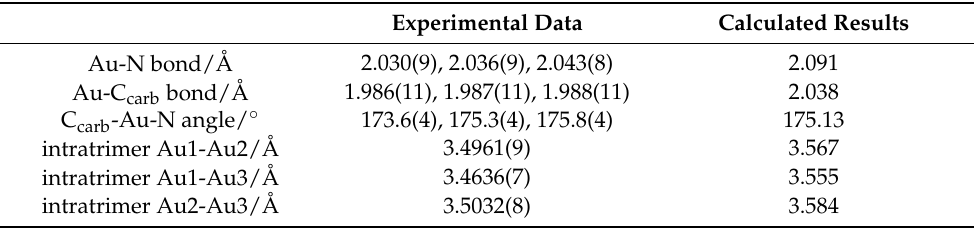
Table 1. Comparison of calculated results from density functional theory (DFT) and experimental data from